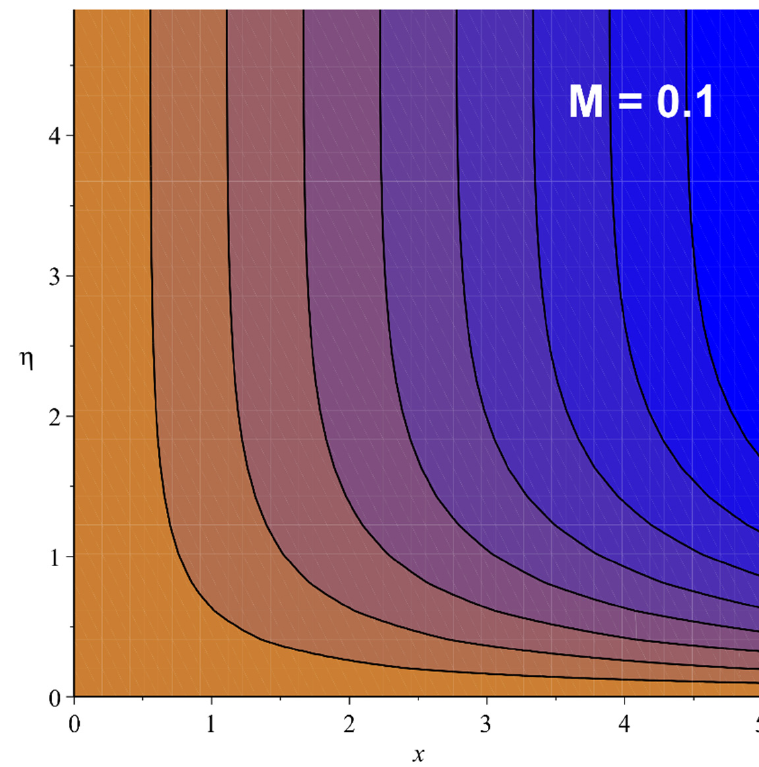
Figure 15. Stream lines when M = .